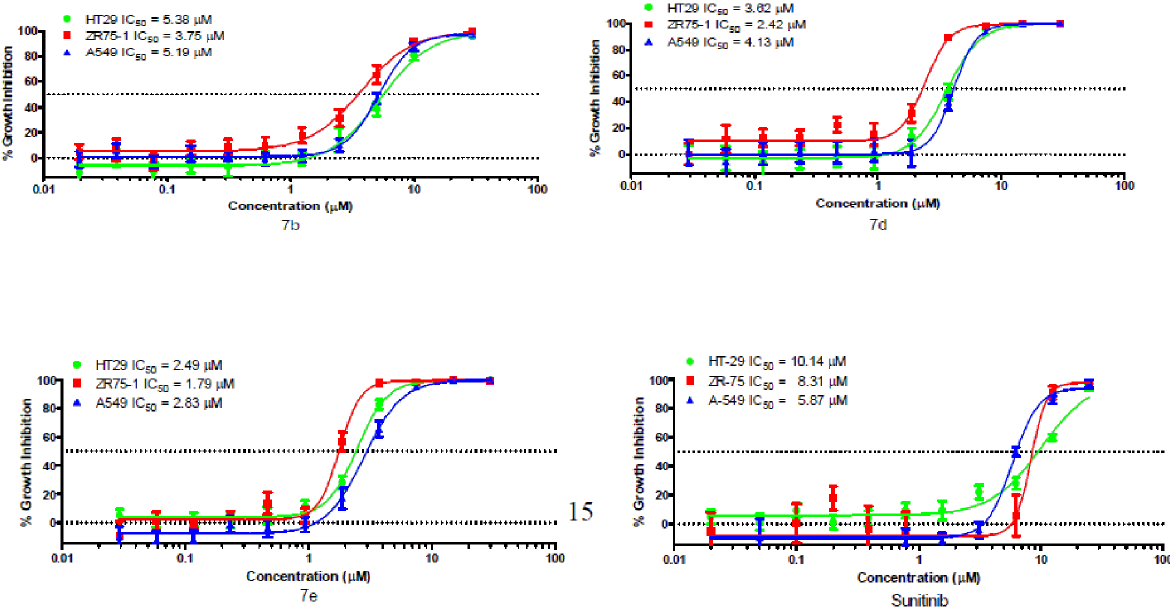
Fig 3. IC 50 of the anti-proliferative activity of compounds 7b, 7d, 7e and sunitinib against HT-29, ZR-75 and A-549 cell lines.